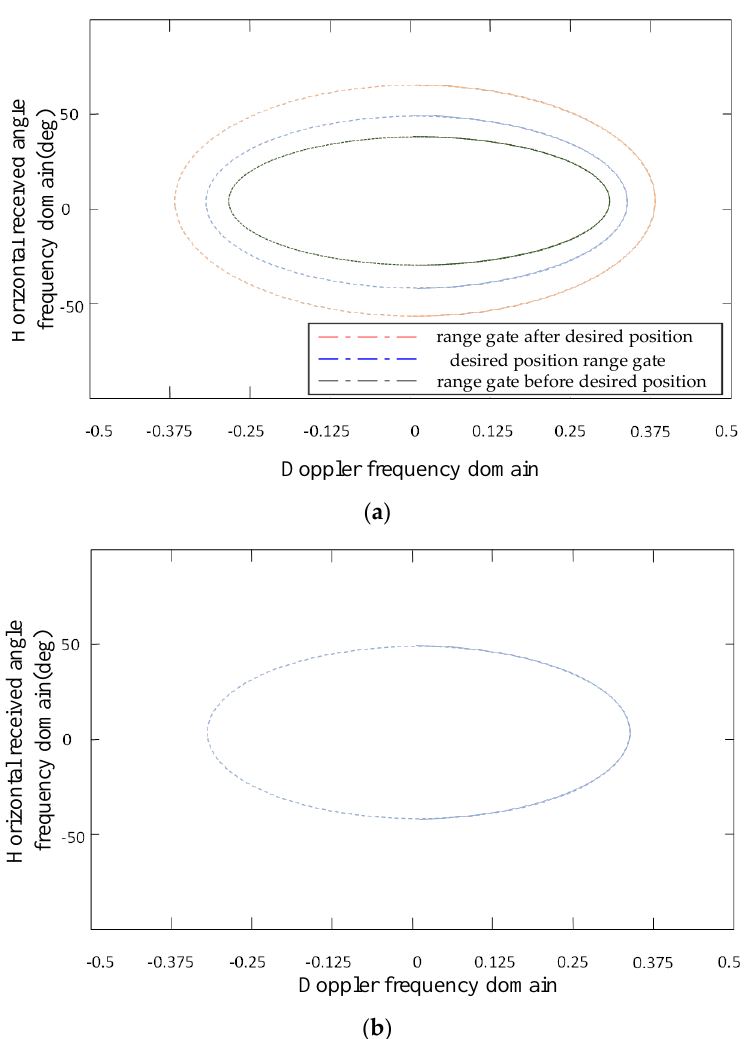
Figure 7. Simulation diagram. ( a ) Multiple range gate clutter ridge distribution ; ( b ) desired range gate clutter ridge distribution.